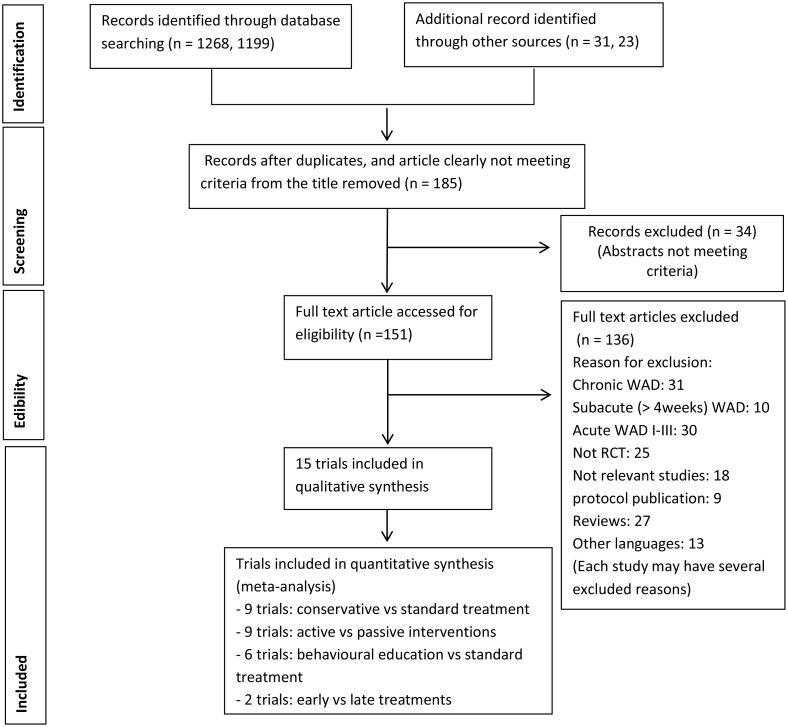
Study selection flow diagram.